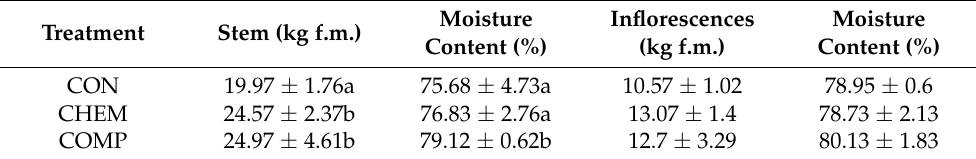
Table 3. Results of biomass collected and moisture content and relative standard deviation. In each column, values with different letters indicate mean values significantly different according to the Tukey’s post hoc test performed on results of ANOVA with p -value < 0.05. CON = Control; CHEM = chemical fertilizer; COMP = Compost. Moisture Inflorescences Moisture Treatment Stem (kg f.m.) Content (%) (kg f.m.) Content (%) CON